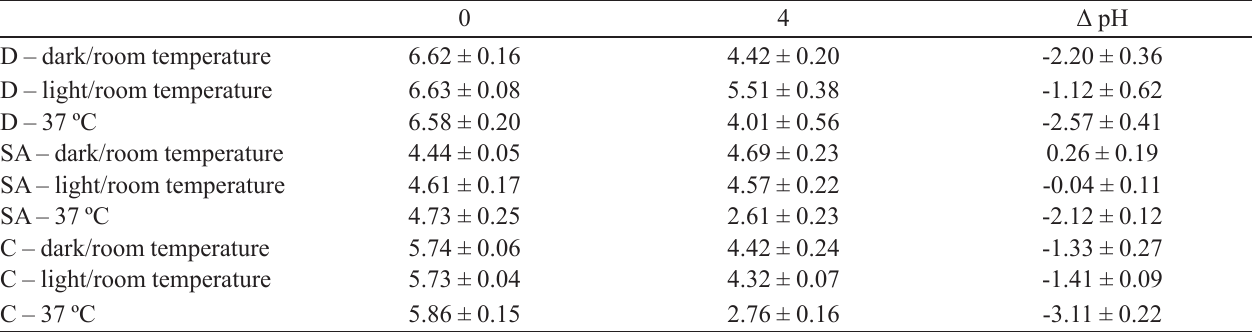
TABLE III – pH values of samples at time 0 and after 4 weeks of storage under different conditions and pH